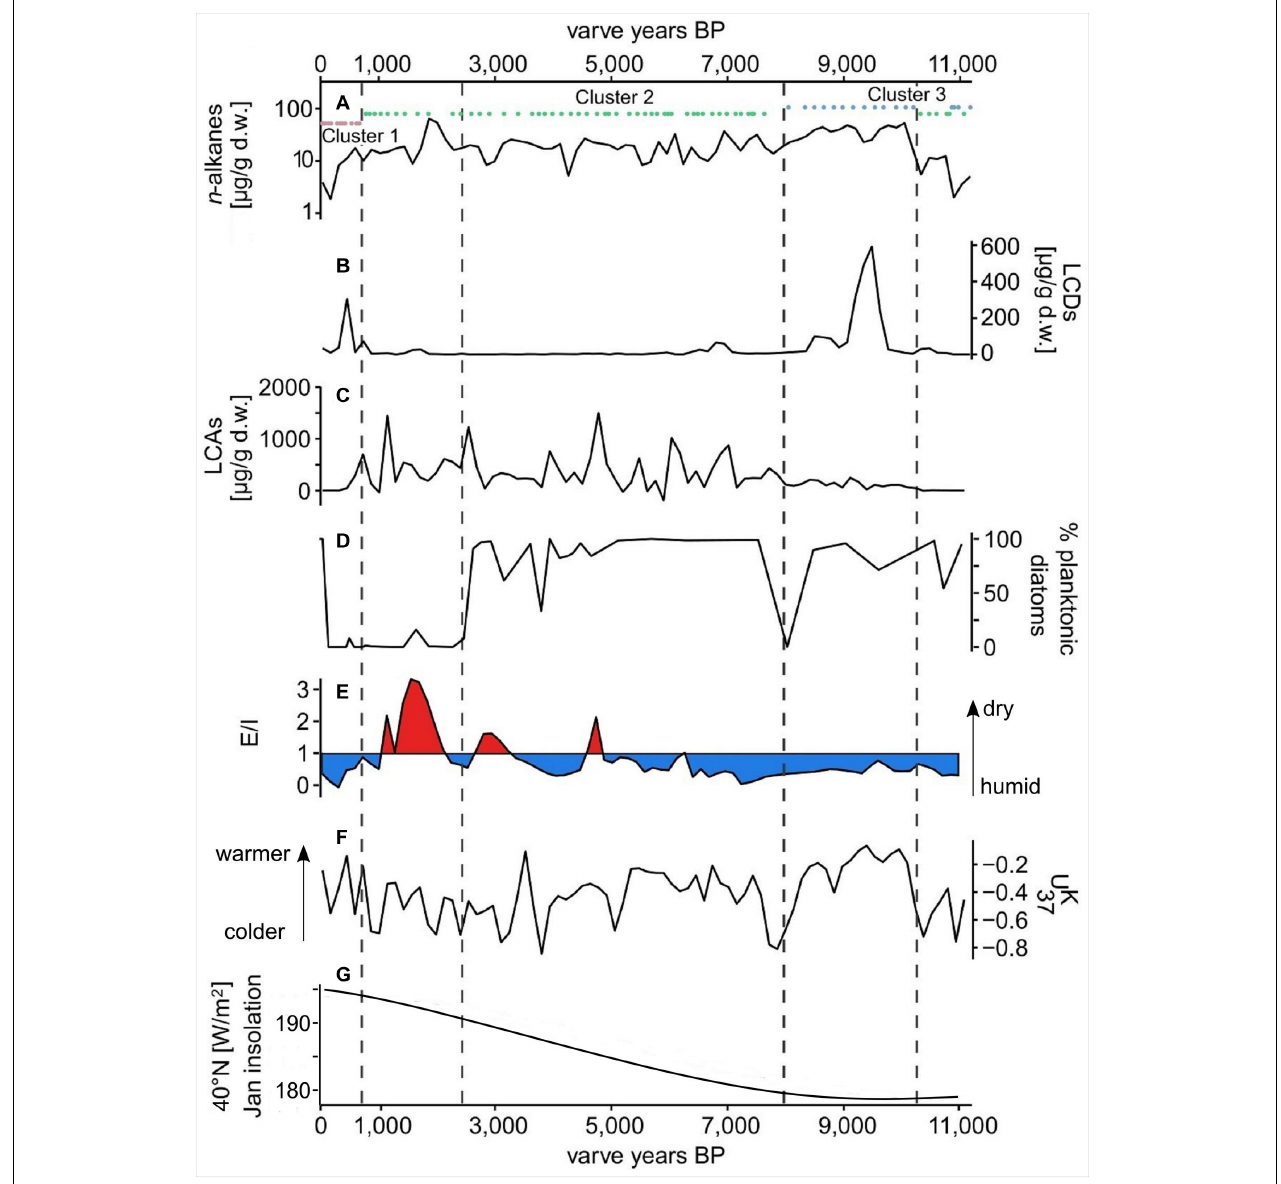
FIGURE 4 | Proxy data from the Lake Chatyr Kol sediment record. (A) total n -alkane amount with n -alkane clusters 1–3; (B) total long-chain alkyl diol amount (LCDs); (C) total long-chain alkenone amount (LCAs); (D) % of planktonic over periphytic diatoms (E) Evaporation-to-inflow ratio (E/I); (F) alkenone